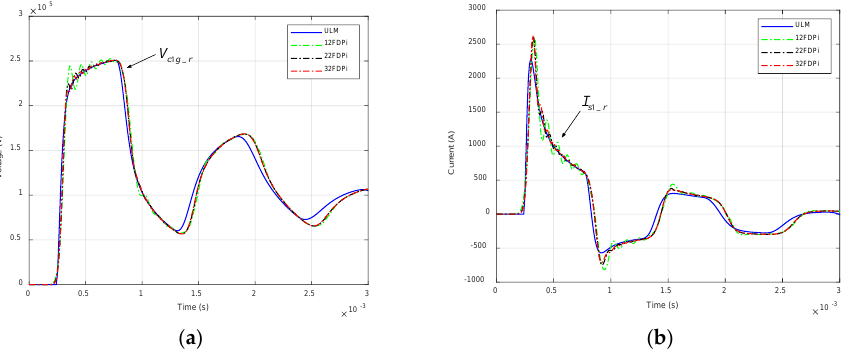
Figure 9. Time response comparison with different number ( N ) of cascaded FDPi sections for Case Study #1. ( a ) V c1g_r . ( b ) I s1_r